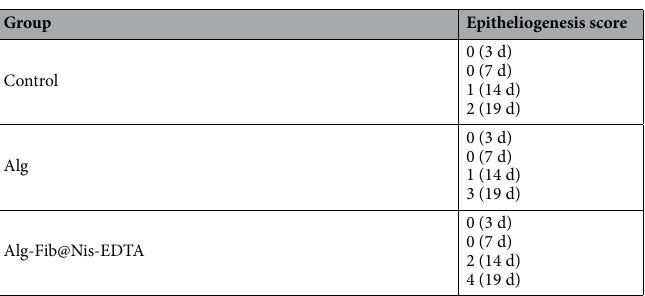
Table 3. Histomorphometric analysis of the groups receiving gauze, Alg hydrogel, and Alg-Fib@ Nis-EDTA hydrogel. Control: negative control, Alg: alginate Hydrogel, Alg-Fib@Nis-EDTA: alginate. + fibrinogen + Nisin + EDTA